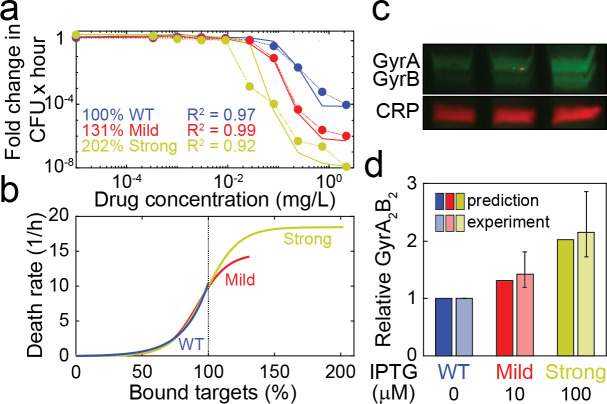
Prediction of relative antibiotic target molecule content from time-kill curves.a, Dose-response curves of E. coli expressing gyrA and gyrB under the same IPTG-inducible promoter (SoA3329) grown in the presence of 10 μM IPTG (mild overexpression; red) and 100 μM IPTG (strong overexpression; yellow). A control strain (SoA3330), which expresses wild-type GyrAB levels and contains a mock plasmid, is grown in the absence of inducer (blue). The x-axis indicates the ciprofloxacin concentration, and the y-axis indicates the fold change in colony forming units over time. The dotted lines indicate experimental data, and the solid lines indicate the model fit. The best model fit was obtained for relative target molecule contents of 131% (mild overexpression) and 202% (strong overexpression) relative to the control strain (WT). b, Death rates of E. coli expressing different levels of GyrAB. The colors represent GyrAB expression conditions as in (a). The x-axis shows the percentage of bound antibiotic target normalized to the control strain; the y-axis shows the death rate δ(x). Each line represents the best fit for δ(x). c, Western blot analysis of GyrA&B in the strains/conditions shown in (a). CRP (cAMP receptor protein) was used as loading control. A representative example of six replicates is shown; see S2 Fig for full blots. d, comparison of theoretical prediction (from (b), solid colors) and GyrA2B2 tetramer levels estimated from relative GyrA&B monomer levels (quantified in (c), translucent colors). For the experimental measurements, the bars indicate the mean, and the whiskers represent the 95% confidence interval.